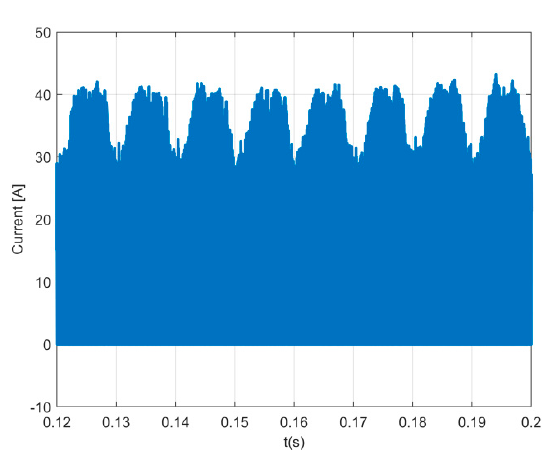
Figure 8. The DC inverter output current (i o1 ).